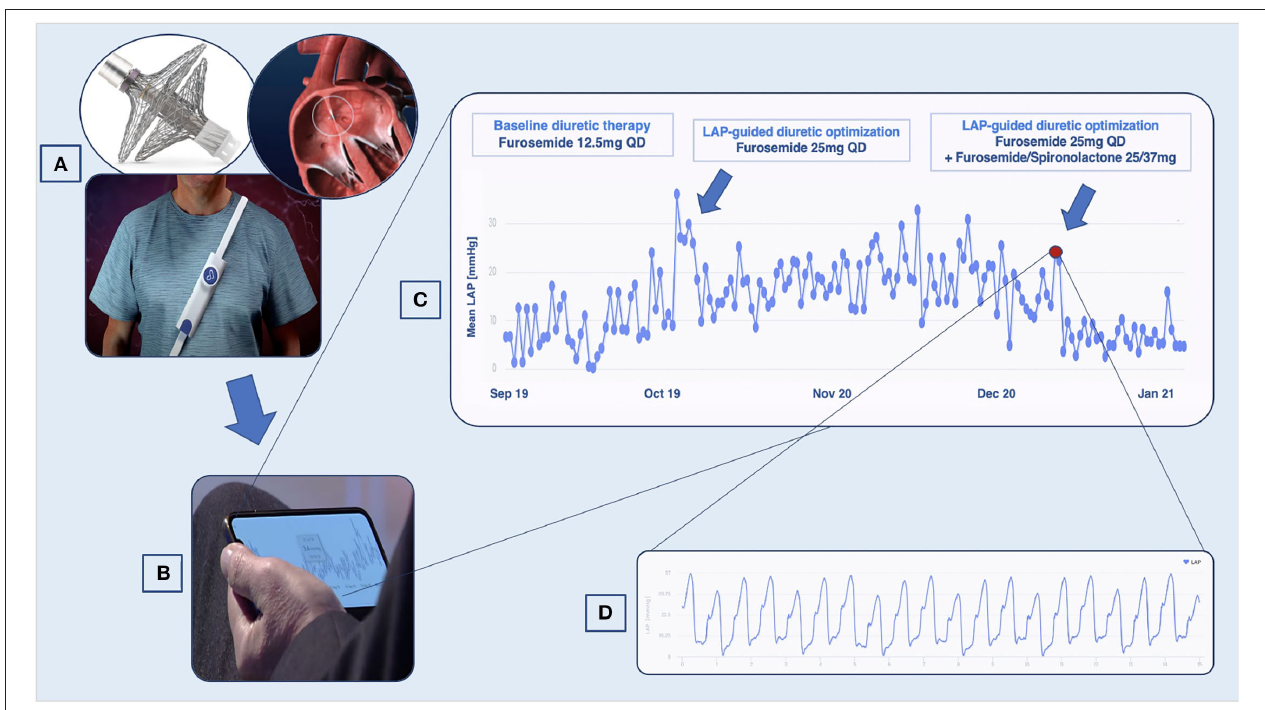
FIGURE 1 | VLAP TM -empowered management of patients with heart failure (HF). (A) Once implanted through the interatrial septum, the device transmits left atrial pressure (LAP) data to an external system, which the patient wears once daily to perform the measurement. (B) Data are accessible to the cardiologist with a secured cloud-based system. (C) LAP trends showing variation suggestive of decompensation. (D) High-resolution LAP